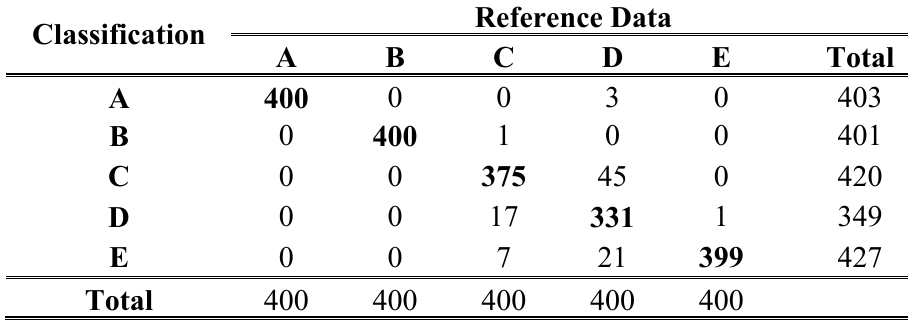
Table 9 . Confusion matrix (# of pixels) using the Gaussian bivariate distribution for PDR - PDS